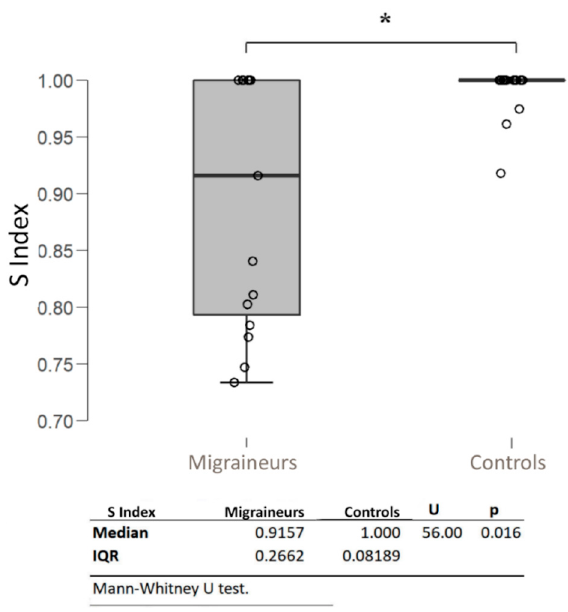
Figure 2. S index distribution among the study populations. Higher variability and lower tail values of the S index are registered in migraine patients confronted with controls. * p <